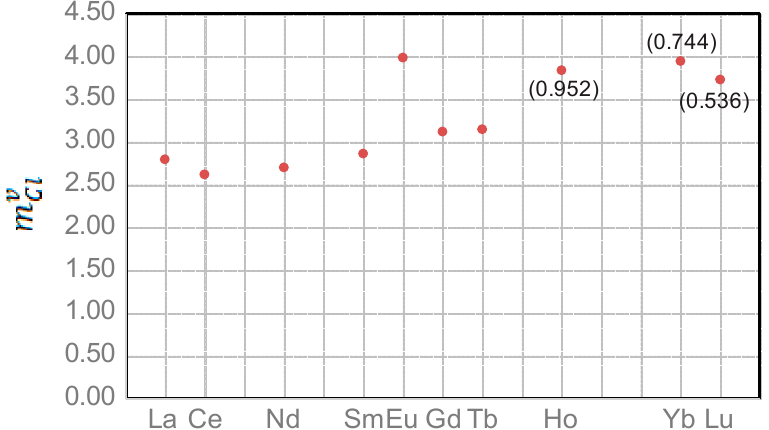
Figure 3. Diagram of m v values required for k REE ≥ 1.0 so that LREEs become fluid compatible. Note that HREEs are exclusively fluid incompatible, partitioning into granitic melts because their k REE are always < 1.0 and would reach maximum values (number in brackets; Table 3) when ( m v ) 3 achieve their respective threshold values.